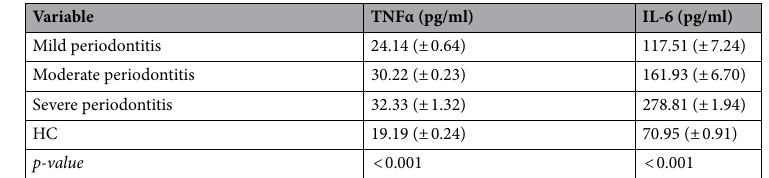
Table 5. Levels of TNFα and IL-6. Data are reported as mean ± SD. The statistically significant difference between different periodontitis patients’ stages and HC (Student t-test, p ≤ 0.001). Data were analyzed using Stata® version 15.